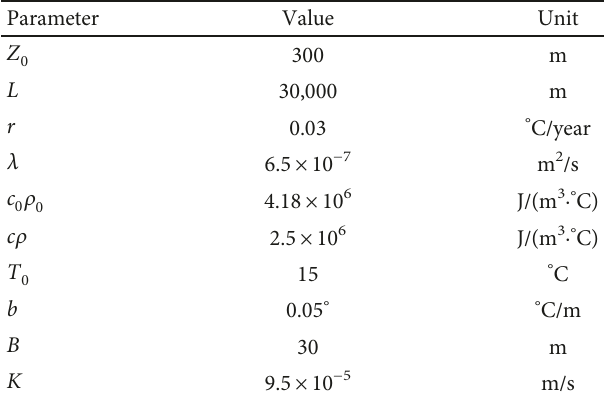
Table 4: Parameters used in the numerical